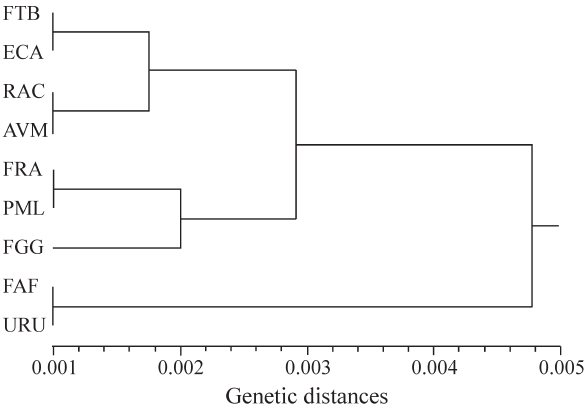
Figure 2 - UPGMA dendrogram reflecting the genetic similarities among nine populations of Araucaria angustifolia based on allelic frequencies of 15